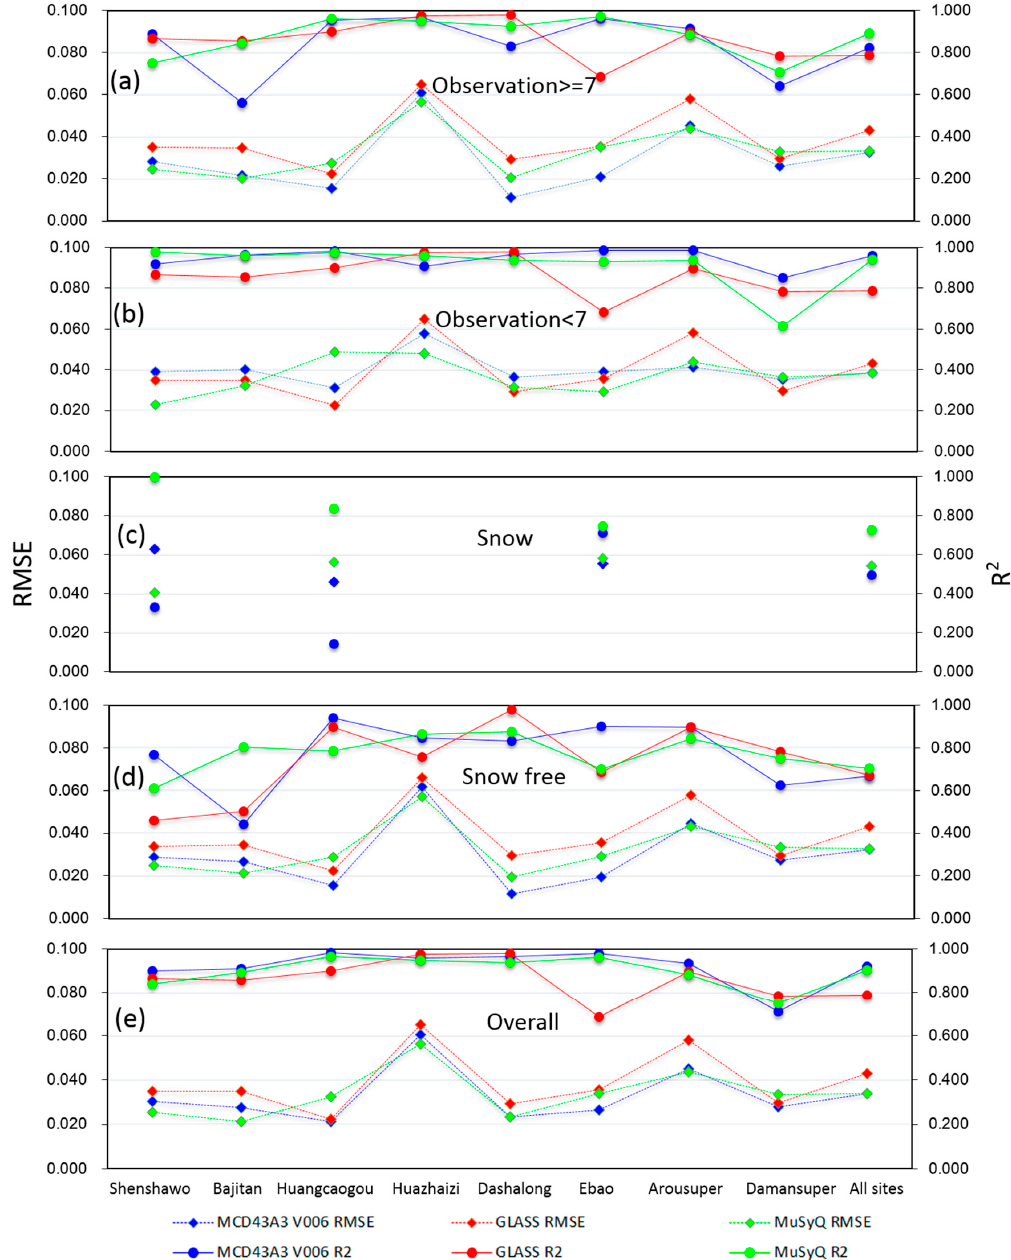
Figure 4. The comparisons of the RMSEs and R 2 between MCD43A3 (V006), GLASS and MuSyQ albedos from the direct comparison with ground-observed albedo: ( a ) Observation ≥ 7, ( b ) Observation < 7, ( c ) Snow, ( d ) Snow free, ( e ) Overall. “Observation < 7” corresponds to the magnitude inversion of MCD43A3 and medium quality inversion of MuSyQ albedo.